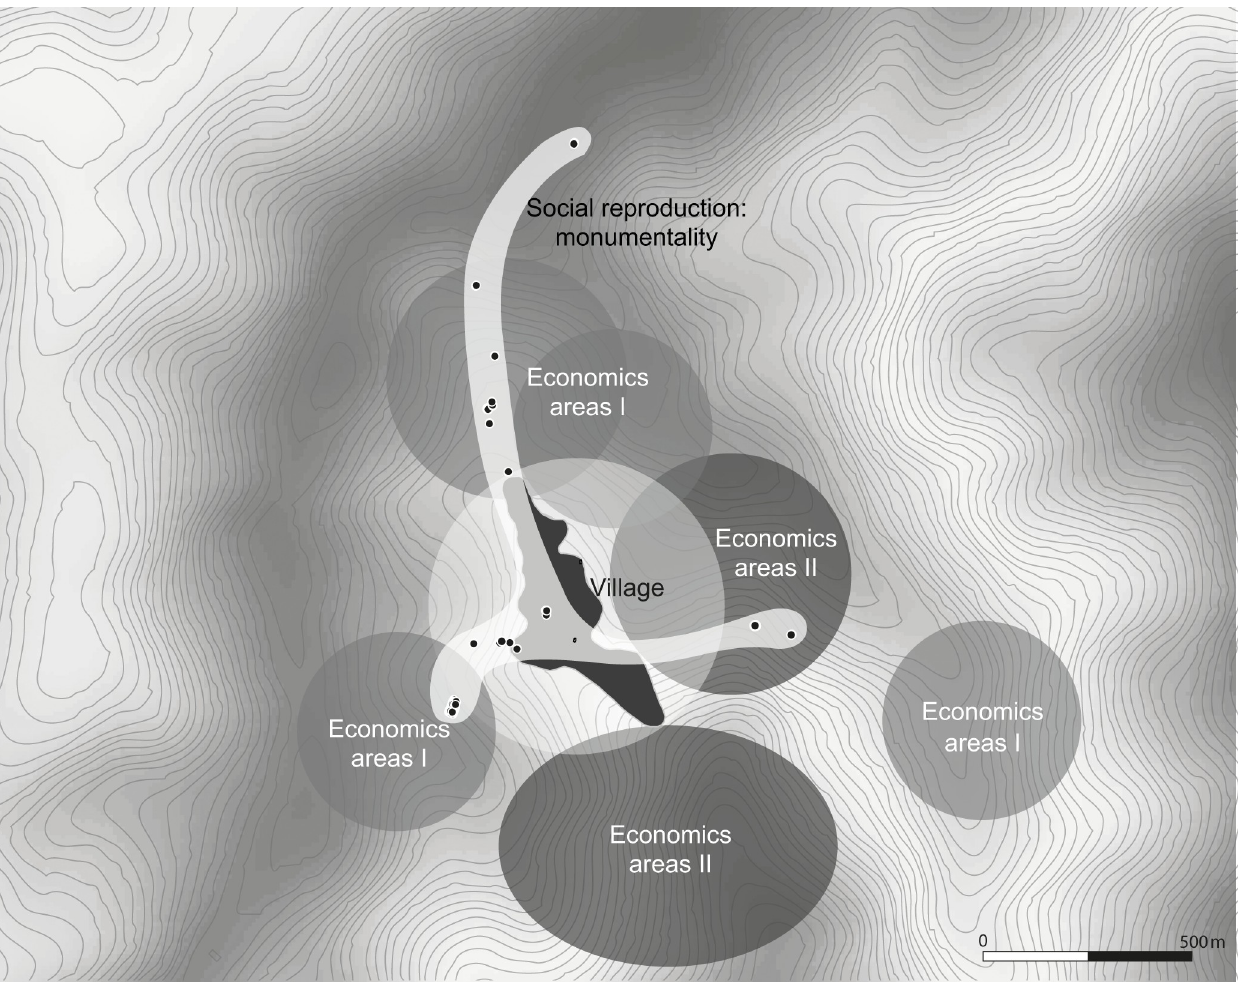
Fig 4. A model of the different spheres of the socially constructed landscape of Ru¨nguzu (graphic: M. Wunderlich, J. Cordts (graphics department of the Institute of Pre- and Protohistoric Archaeology Kiel); DEM based on CGIAR-CSI SRTM data. DEM republished from Jarvis A., H.I. Reuter, A. Nelson, E. Guevara, 2008, Hole-filled seamless SRTM data V4, International Centre for Tropical Agriculture (CIAT), available from http://srtm.csi.cgiar.org, under a CC BY license, with permission from Alliance of Bioversity International and CIAT, original copyright 2004–2021).